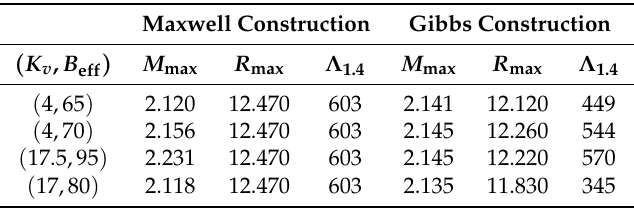
Table 2. Table of characteristic parameters associated with a given hybrid equation of state model. The parameter pairings in the leftmost column denote the vBag parameters for the quark model that the DBHF model transitions into. For reference, the purely nuclear DBHF model yields values of ( M max , R max , Λ 1.4 ) = ( 2.298 M , 12.47, 603 ) . The maximum mass values are in units of M (cid:12) values are in units of km, and Λ 1.4 is